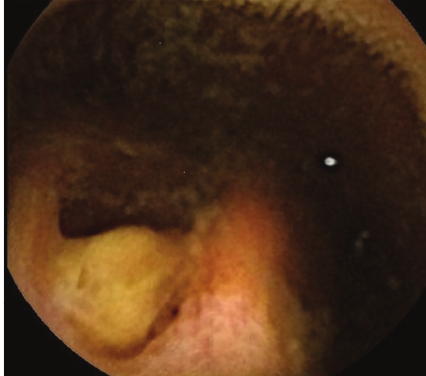
Figure 1: Capsule endoscopic finding: a tumor arising from small intestine with intraluminal growth with ulcerated surface.